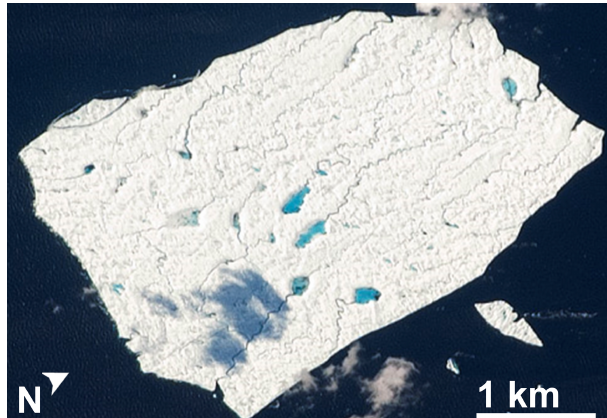
Figure 1. Ice island with melt ponds and meltwater channels on the Atlantic Ocean close to Newfoundland, Canada. Information: image of Petermann Ice Island A, fragment 2 captured by an as- tronaut from the International Space Station on 29 August 2011. Source: ISS Crew Earth Observations experiment and Image Sci- ence & Analysis Laboratory, Johnson Space